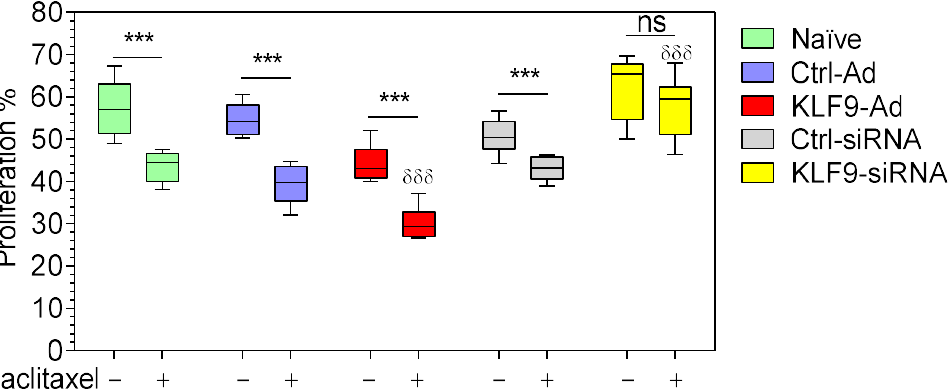
Figure 5. Fluorescent micrographs illustrate how KLF9 modulates paclitaxel’s effect on proliferation in malignant melanoma-derived cell lines. RPMI-7951 (( A ) top graphs) and A375 cells (( B ) top graphs) were plated on cover slips 24 h before viral transduction or siRNA transfection. Then, the cell monolayers were incubated for another 24 h followed by paclitaxel treatment (100 nM for 24 h). Cells were immunoprobed against KI67 (red) and KLF9 (green) antibodies, DAPI (blue) was used as a nuclear marker. Images were captured using an OLYMPUS IX73 inverted fluorescent microscope and cellSens Dimension 1.9 software (original magnification: 600; scale bar = 10 µM). KI67 fluorescence quantification was carried out using imagej online software, as described in the methods section. The extracted values for KI67 positive nuclei were plotted using Graph-Pad Prism software (box and whiskers bottom graphs). Significant difference was determined using ANOVA with Tukey’s correction for multiple comparisons. ns p > 0.05, *** p ≤ 0.001 vs. non-stimulated cells, δδδ p ≤ 0.001 vs. paclitaxel-treated naïve cells.